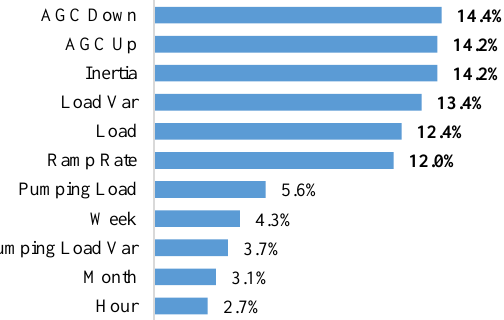
Figure 5. Ranking of frequency-sensitive features by importance.